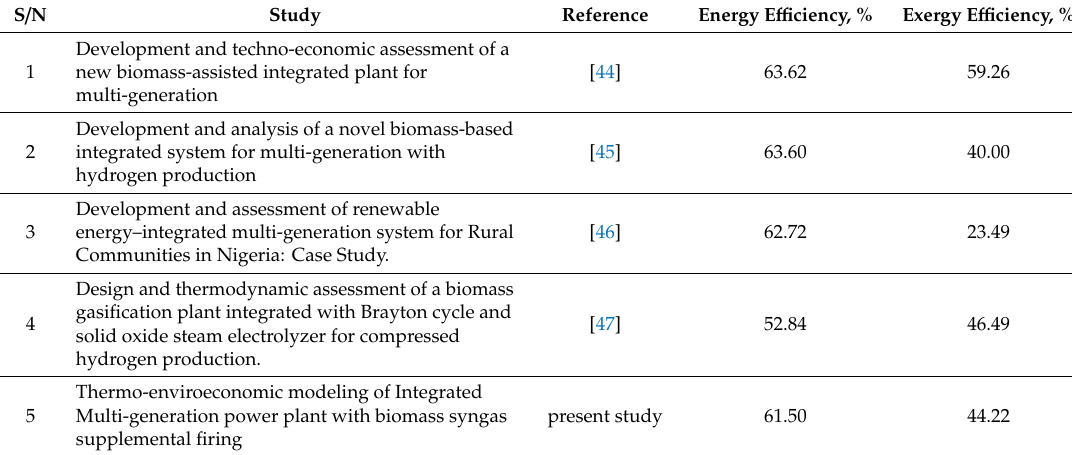
Table 5. Results validation with